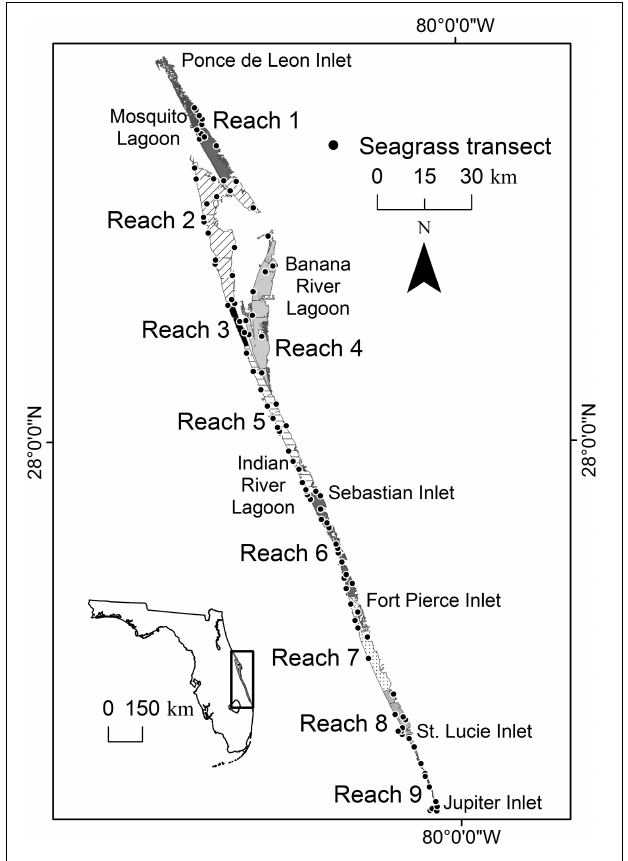
FIGURE 1 | Map showing the location of the Indian River Lagoon, five inlets, nine reaches, and fixed transects where seagrass was surveyed.